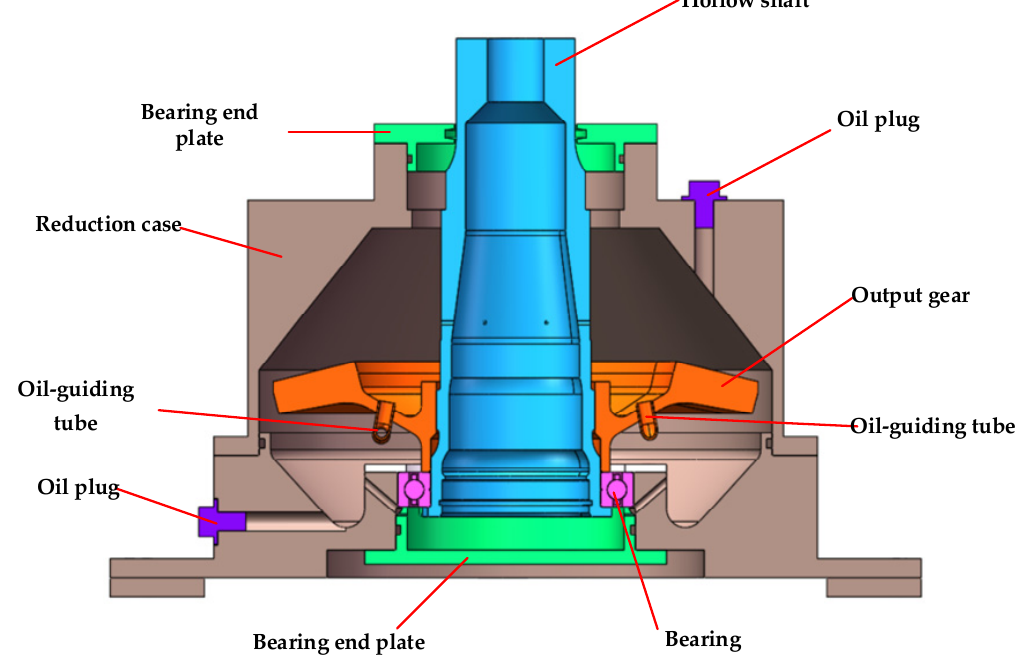
Figure 1. Schematic diagram of main gearbox oil-guiding splash lubrication